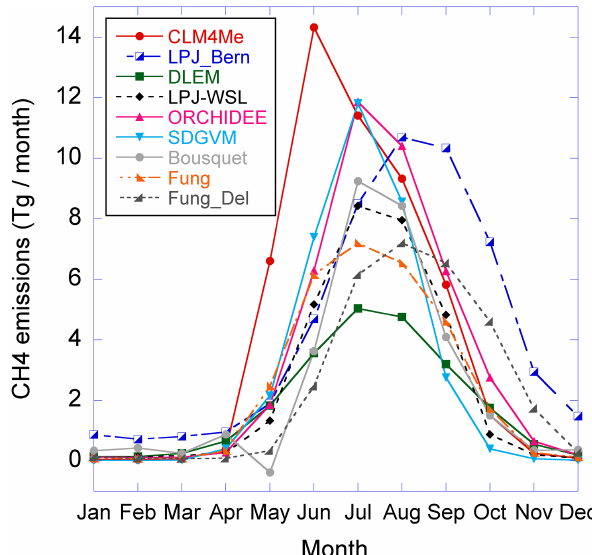
Figure 1. A comparison of seasonal cycles in northern wetland emissions (>50 ◦ N) from Fung et al. (1991) with a seasonal cy- cle delayed by 1 month (Fung_Del), mean annual emission data for 1993–2004 from wetland process models obtained as part of the recent WETCHIMP model comparison (CLM4Me, LPJ_Bern, DLEM, WSL, ORCHIDEE, SDGVM; Melton et al., 2013) and mean annual emission data for 2005–2009 from the methane model inversion study of Bousquet et al.